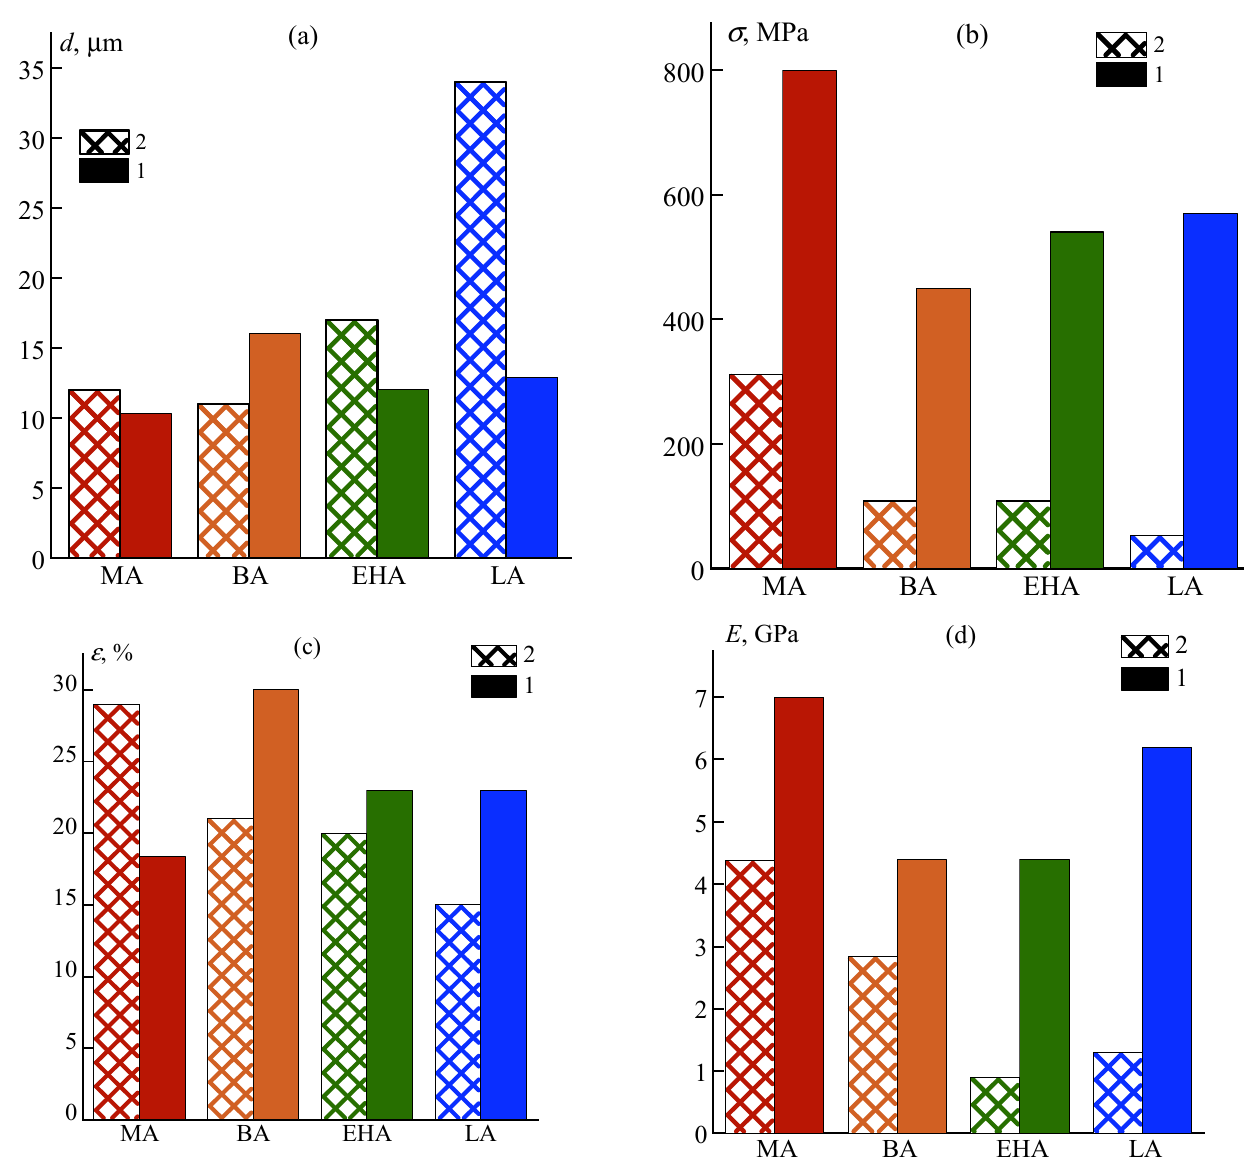
Figure 9. Mechanical characteristics of fibers made from copolymers with various alkyl acrylate comonomers: ( a ) diameter; ( b ) tensile strength; ( c ) elongation at break; ( d ) elastic modulus; 1—AlkA1 series with M w ~150 kg/mol, 2—AlkA2 series with M w ~50 kg/mol.